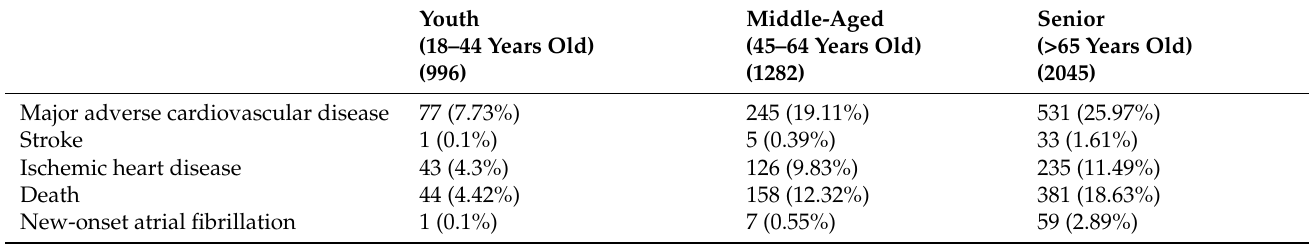
Table 4. Major adverse cardiovascular events and new-onset atrial fibrillation by age